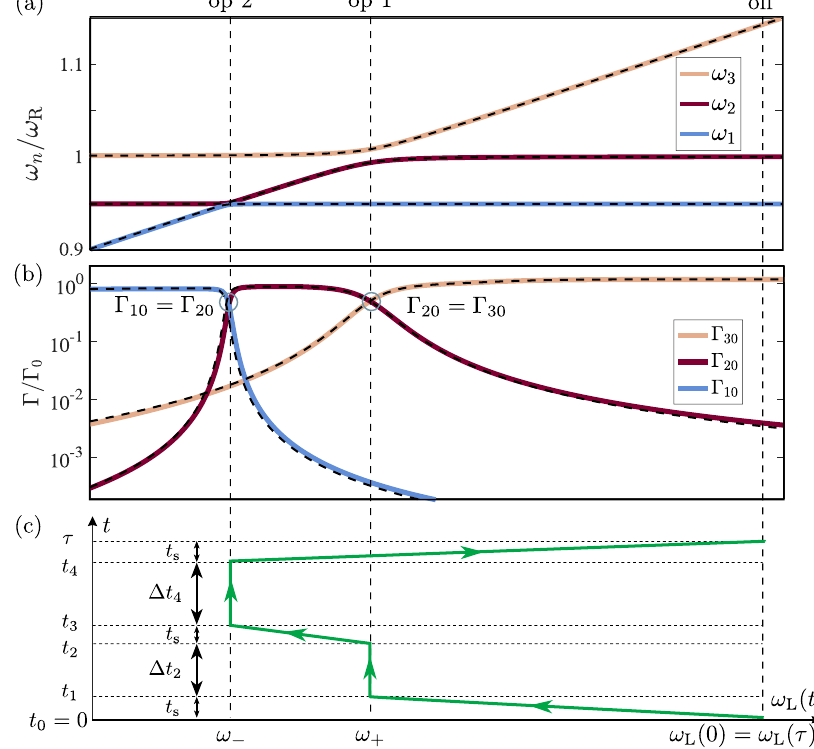
Fig. 2 Low-energy level structure, relaxation rates, and the proposed initialization protocol. a Instantaneous eigenfrequencies and b relaxation rates of the lowest three excited states as functions of the bare left-resonator angular frequency. We show with dashed lines the corresponding analytic results from the Jacobian diagonalization [see Methods and Eqs. (10) – (12)] on top of those resulting from numerical diagonalization ( solid lines ). Vertical dashed lines denote the operative stages of the protocol, where ‘‘ op ’’ stands for operation point and ‘‘ off ’’ refers to the state where the coupling between the qubit and the engineered environment is very weak. We use the parameters shown in Table 1. c Initialization protocol in terms of the control parameter ω L ( t ) (see text for